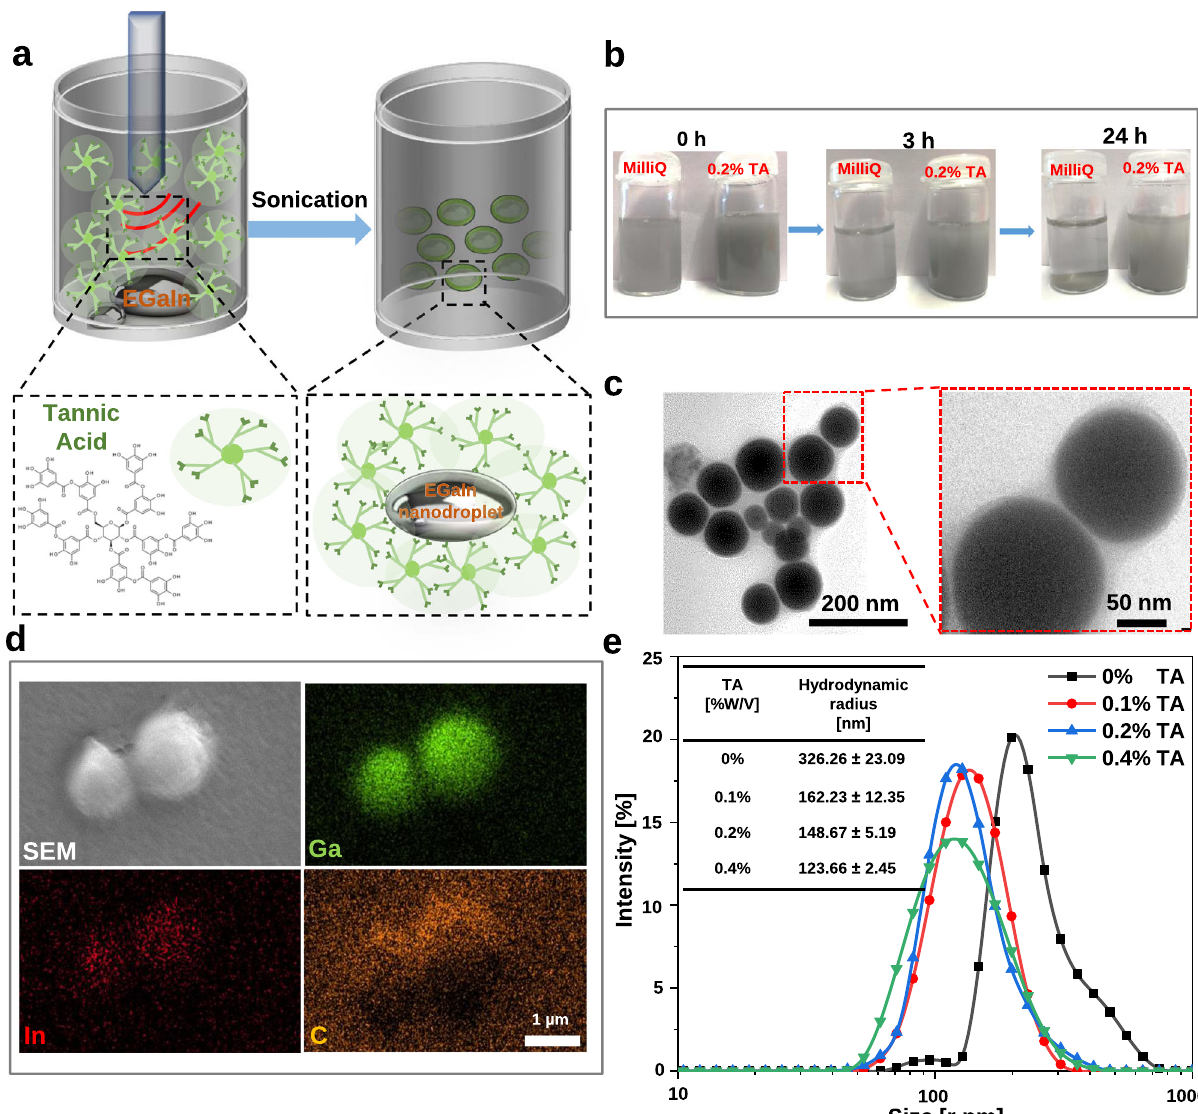
Fig. 1 Production of EGaIn nanodroplets. a Schematic illustration of sonicating eutectic gallium – indium (EGaIn) in tannic acid (TA) solution and EGaIn droplets shelled by tannic acid. b Photos for time-dependent dispersion of liquid metal (LM) in water and tannic acid solution after ultrasonication. c TEM images of tannic acid-coated liquid metal nanodroplets (TA-LM) with core – shell nanostructure. A representative image of three individual experiments is shown. d Cryo-scanning electron microscopy (Cryo-SEM) image of LM droplets. EDS mapping of Ga (gallium), In (indium), and C (carbon). A representative image of three independent samples is shown. e DLS analysis of LM droplets. Inset table: feeding compositions of LM/TA mixture solution and LM droplets